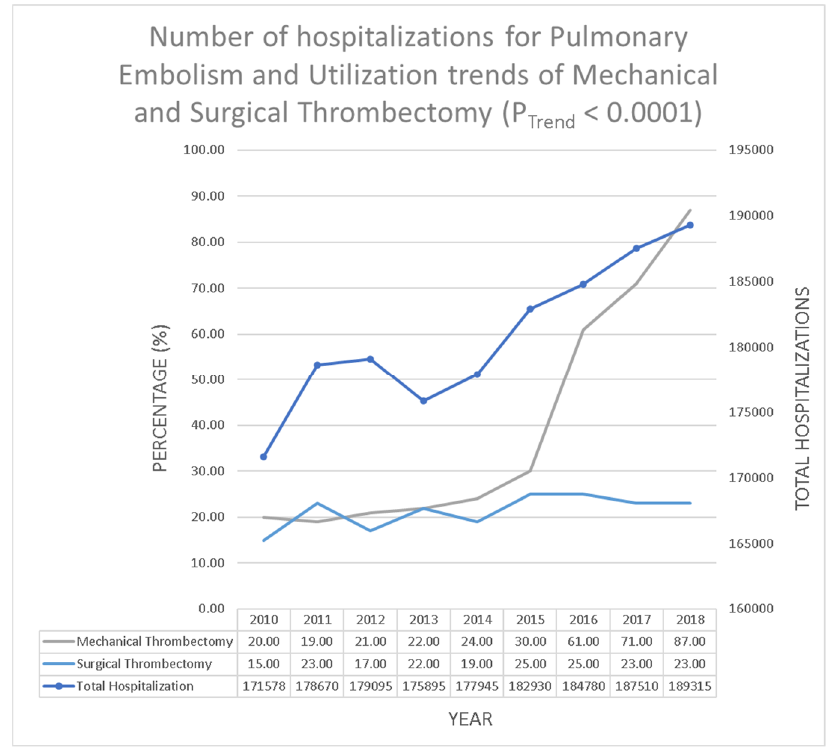
Figure 1. Number of hospitalizations for pulmonary embolism and utilization trends of mechanical and surgical thrombectomy ( P Trend < 0.0001).